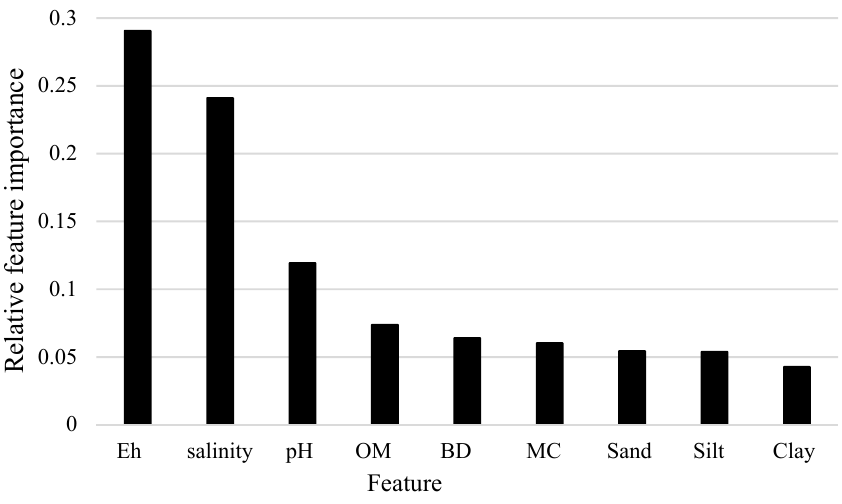
Figure 4. The parameters importance in halophyte classification by random forest.